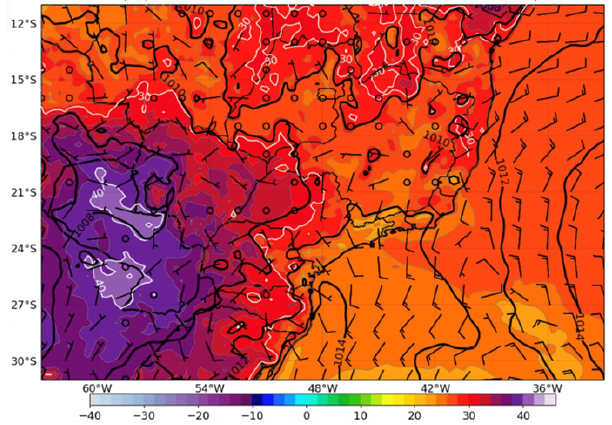
Figure 13. Global Forecast System (GFS) analysis at 18:00UTC for 15 February 2022, for the Petrópolis region. Shades represent surface temperature, isolines represent sea level pressure, and the barbs show wind speed (in